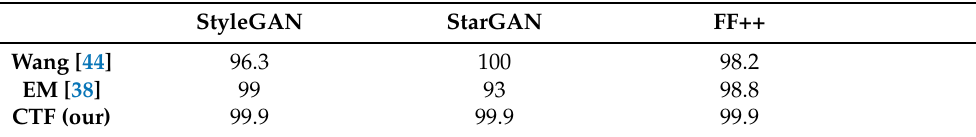
Table 3. Comparison with state-of-the-art methods [38,44]. Classification of Real images (CelebA and FFHQ) vs. Deepfake images. The CTF approach was tested and compared also considering the dataset of Deepfake video’s FaceForensics++ (FF++). Average Precision values (%) of each classification task are